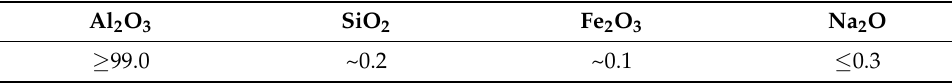
Table 4. Physical and chemical properties of colloidal silica. Table 3. Chemical compositions of the white fused alumina powders (mass fraction %).